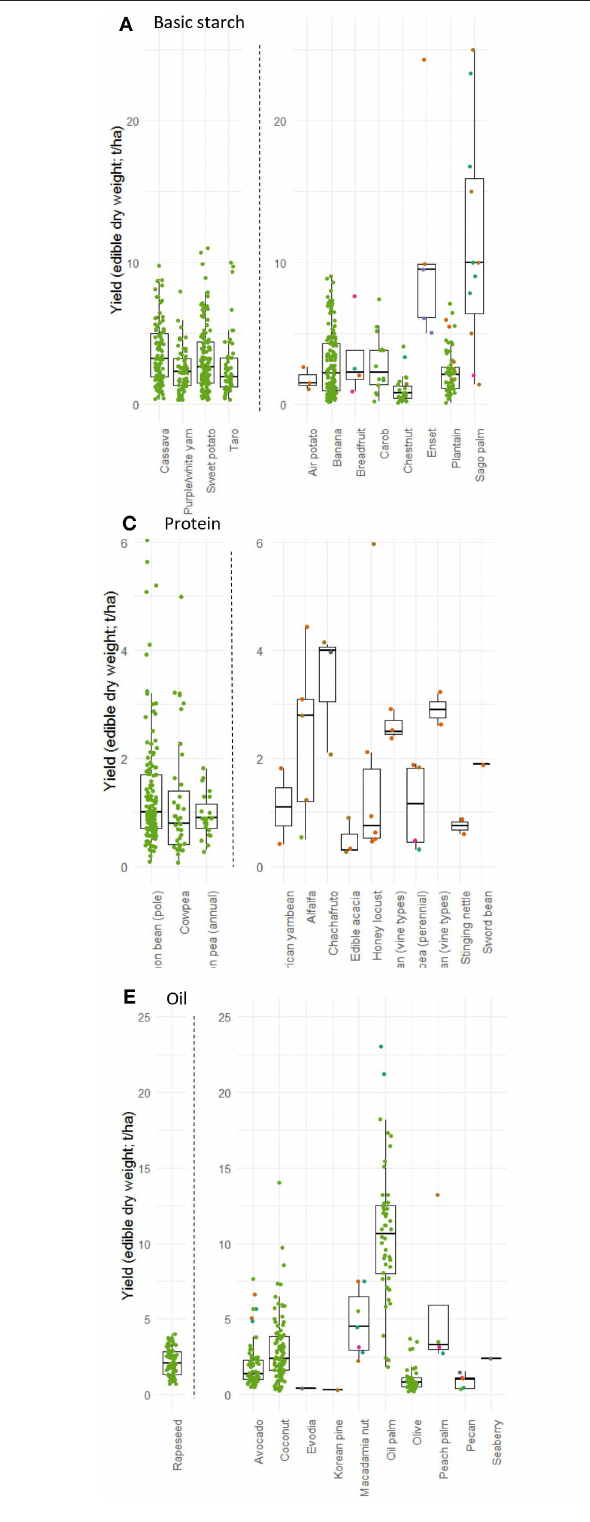
Frontiers in Sustainable Food Systems |